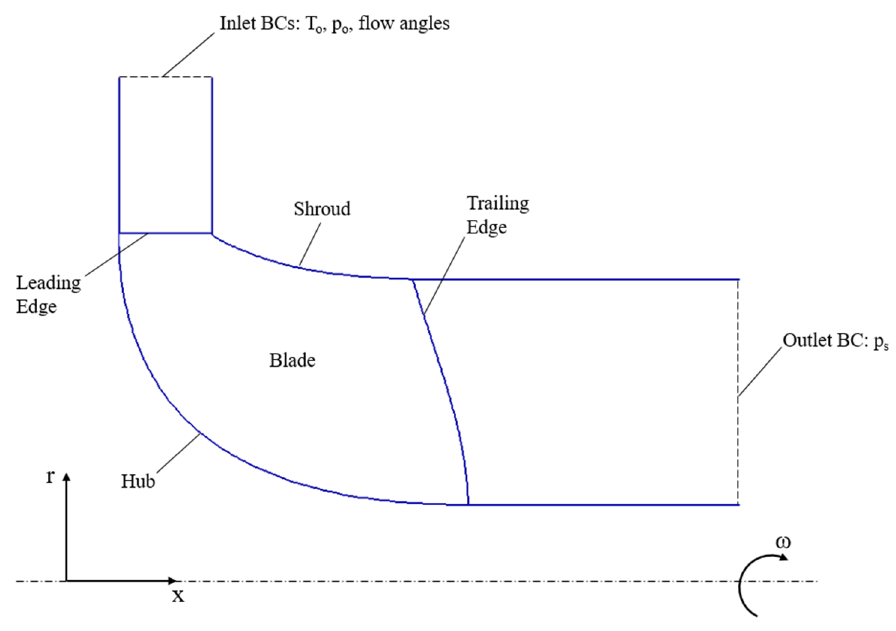
Figure 11. Turbine rotor meridional view and boundary condition locations. Table 2. Turbine rotor boundary conditions.